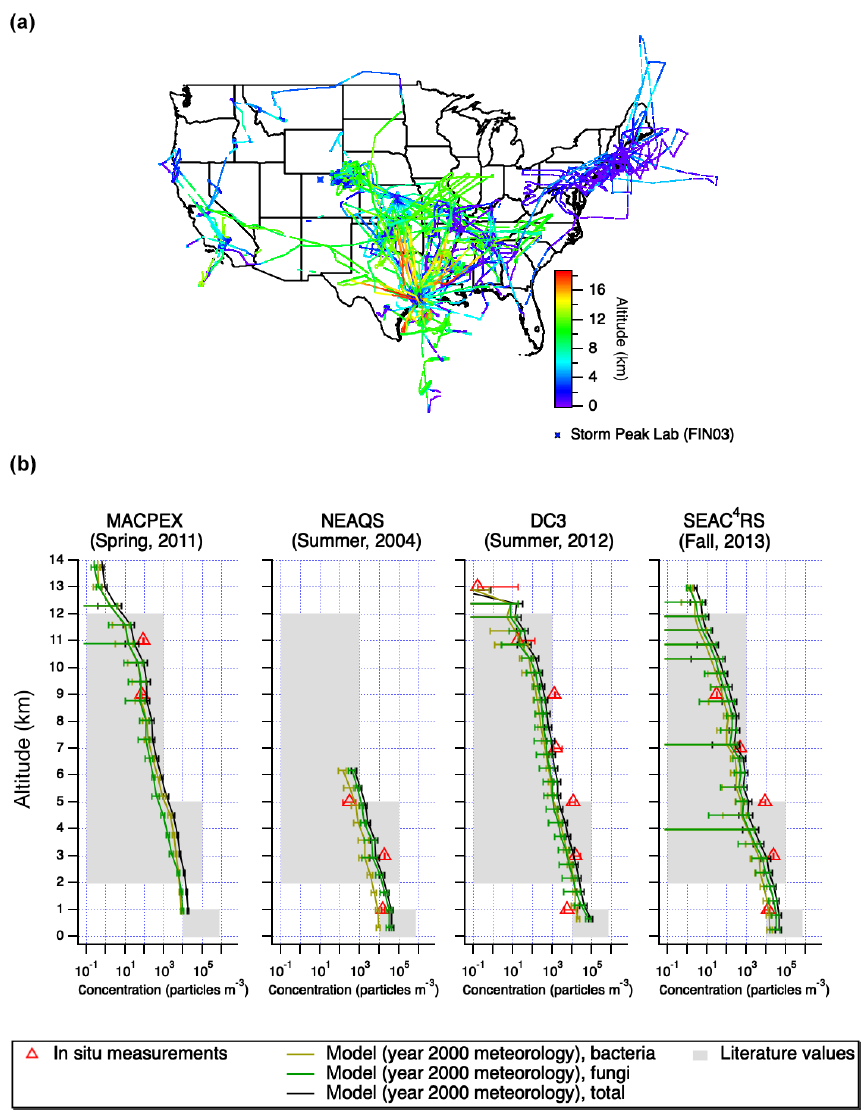
Figure 1. Flight tracks (a) and altitude-resolved concentrations of particles categorized as bioaerosol (b) during four aircraft studies: MACPEX, NEAQS, DC3, and SEAC 4 RS. The PALMS size range is 0.3–2µm for MACPEX and 0.3–4µm for all other campaigns. Note there were no MACPEX data for altitudes less than 2km. The error bars on PALMS data correspond to particle type assignment confidence estimated using laboratory data and SVMs algorithm. Results are shown for the GLOMAP model using year 2000 meteorology sampled at the measurement locations. Error bars on model results correspond to standard deviations in the model estimates in each altitude bin. Concentrations for both model and PALMS measurements are reported in particles per ambient cubic meter. Typical literature values are estimated using Burrows et al. (2009) for surface values ( < 1km), Twohy et al. (2016) and Bowers et al. (2012) for 2–5km, and Twohy et al. (2016) for